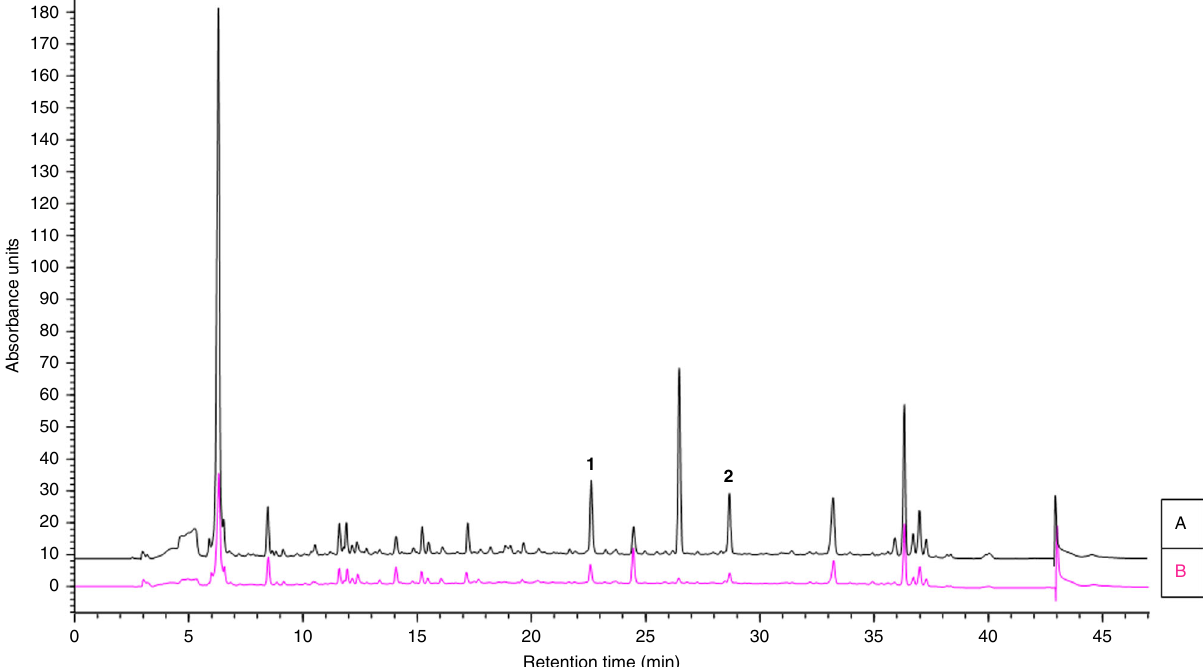
Fig. 2 Escovopsis pathogenesis involves upregulation of small molecule virulence factors. HPLC pro fi les ( λ = 254 nm) of ethyl acetate extracts of a L. gongylophorus infected with E . weberi strain G; b E . weberi strain G axenic culture. Melinacidin IV, 1 ; shearinine D,